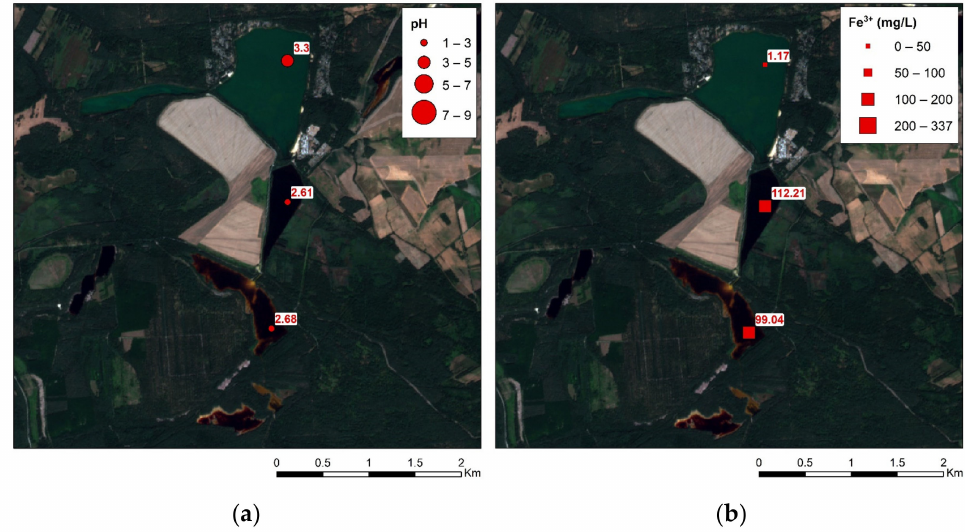
Figure 6. Measurements of ( a ) pH values and ( b ) Fe 3+ concentrations for the selected samples of the study area, collected in September 2019. Background image is a Sentinel-2 RGB-composite of the visible bands acquired during 5–15 September 2019.